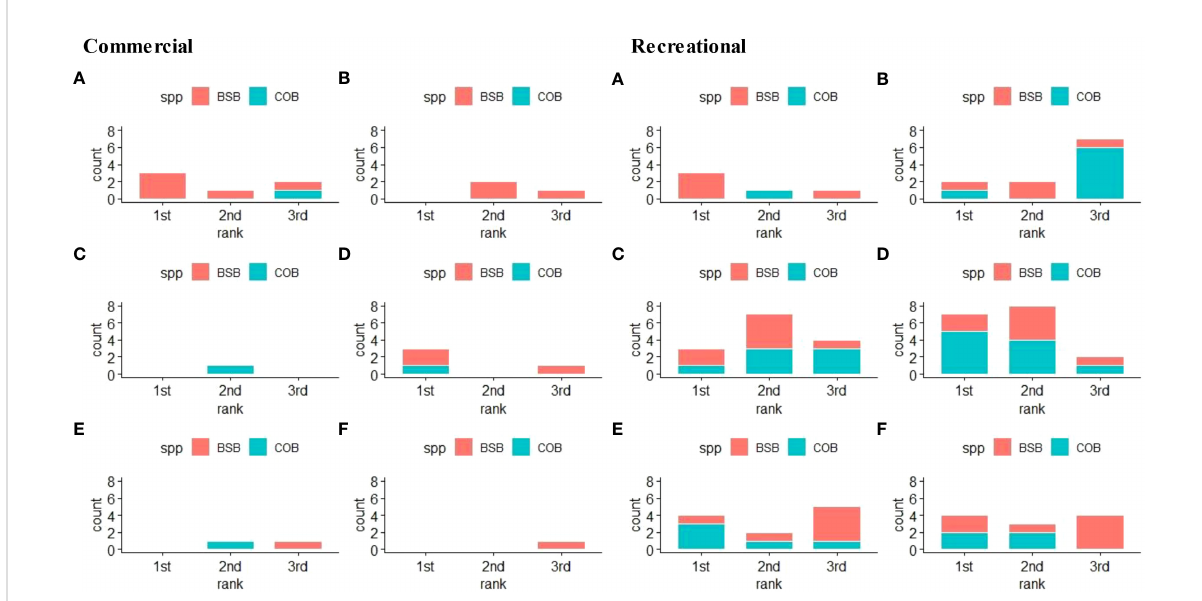
FIGURE 1 Tallied responses to Interview Question 2 which asks fi shers to identify their top three conceptual objectives from a list provided by the interviewer. Conceptual objectives were ranked 1st, 2 nd , or 3rd by commercial fi shers (left) and recreational fi shers (right) for black sea bass (red) and cobia (blue). Options for ranking were (A) “ Catching the greatest number of pounds, ” (B) “ Catching the greatest number of fi sh, ” (C) “ Catching the largest size fi sh, ” (D) “ Maximizing the length of the season, ” (E) “ Conservation of the resource, ” and (F) “ Increased access or opportunity within the fi shery. ” .